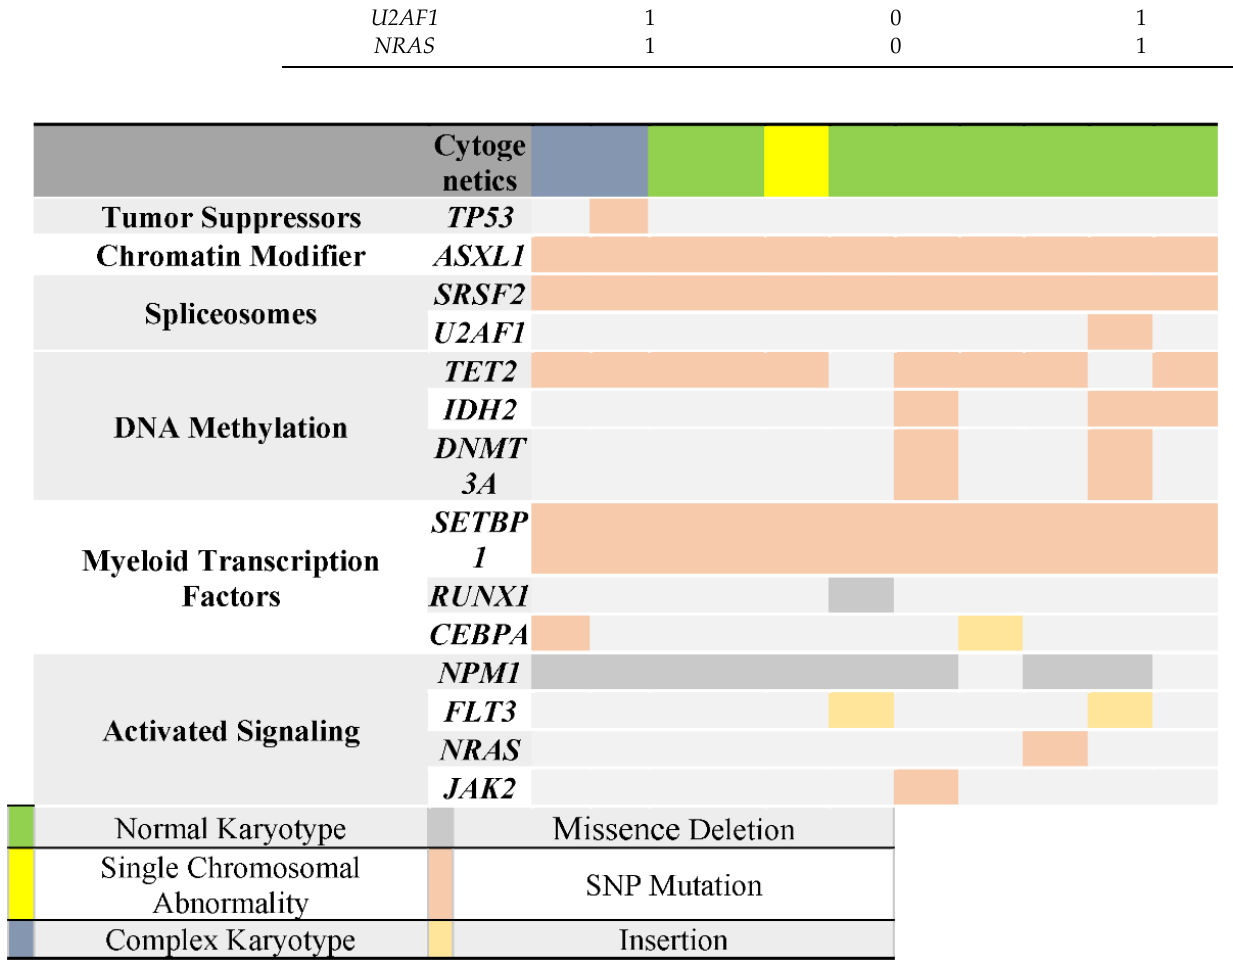
Figure 3. Mutation status according to patient characteristics & cytogenetics. The far-left column lists the 14 genes that were tested in the panel. Each column represents a single patient, and each colored bar indicates the presence of a mutation in the indicated gene. In addition, each color represents the type of mutation and cytogenetic status, as shown above. This illustrates the spectrum of coexistent mutations in all patients.